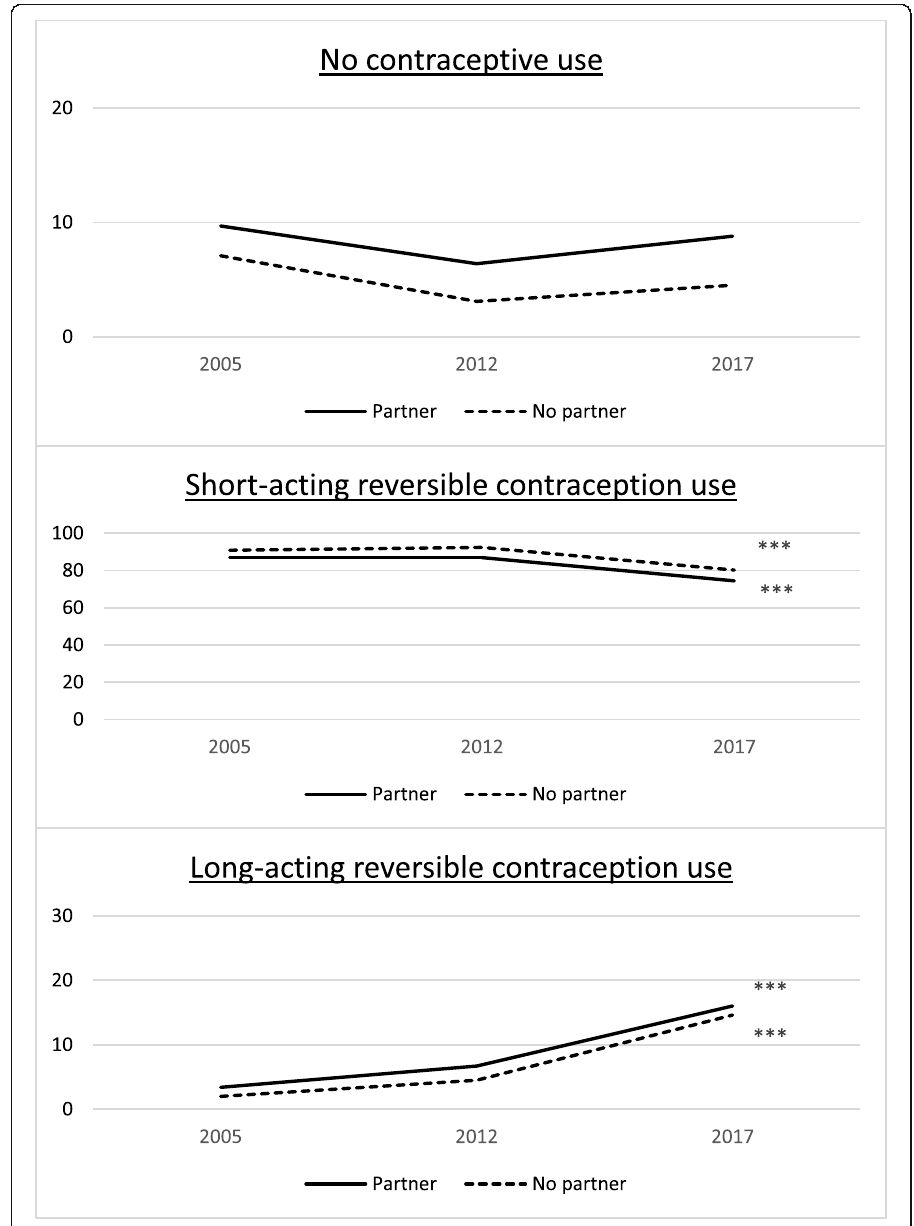
Fig. 6 Trends over time in contraceptive use by partner status. Trends differed significantly by education group ( p =.152). Significance indicated; ** p <0.01, *** p